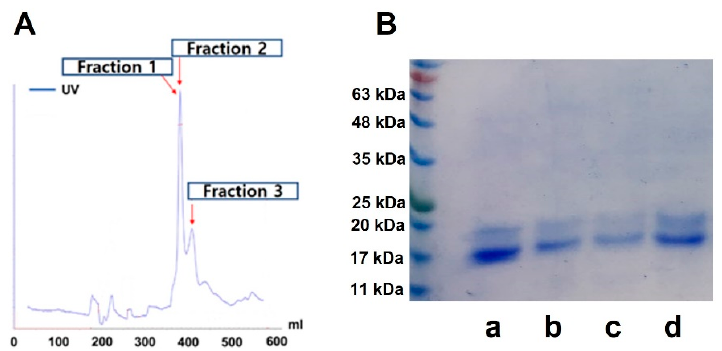
Figure 1. Gel chromatogram and gel-electrophoresis of phycobiliprotein according to its size . ( A ) Gel chromatogram after ammonium sulfate precipitation and ion exchange chromatography. Three peaks were observed, called Fraction 1, Fraction 2, and Fraction 3 in fraction order. ( B ) SDS-PAGE gel electrophoresis of the fractionated phycobiliproteins, a: control C-Pc; b: Fraction 1; c: Fraction 2; d: Fraction 3.